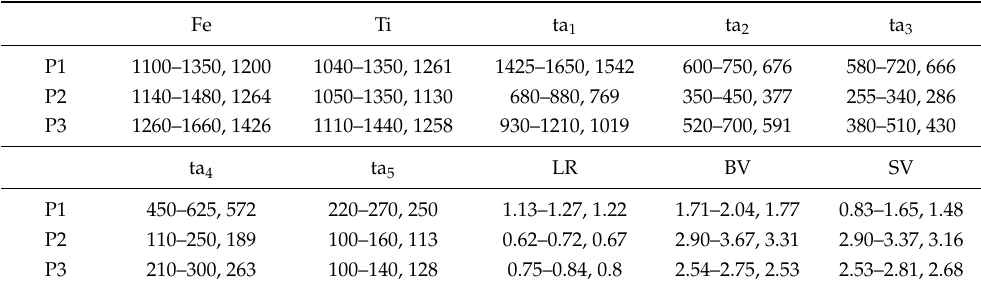
Table 3. Male adults of Microtendipes bimaculatus sp. nov. Length (in µ m) and proportions of leg ( n =